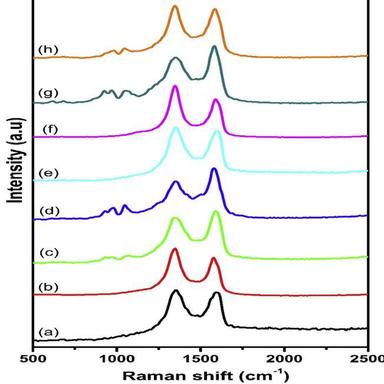
Raman spectra of (a) GO, (b) rGO, (c) PPy/GO, (d) PPy/rGO, (e) MWCNT/GO/NCC (f) MWCNT/rGO/NCC, (g) PGMGN and (h) r-PGMGN.